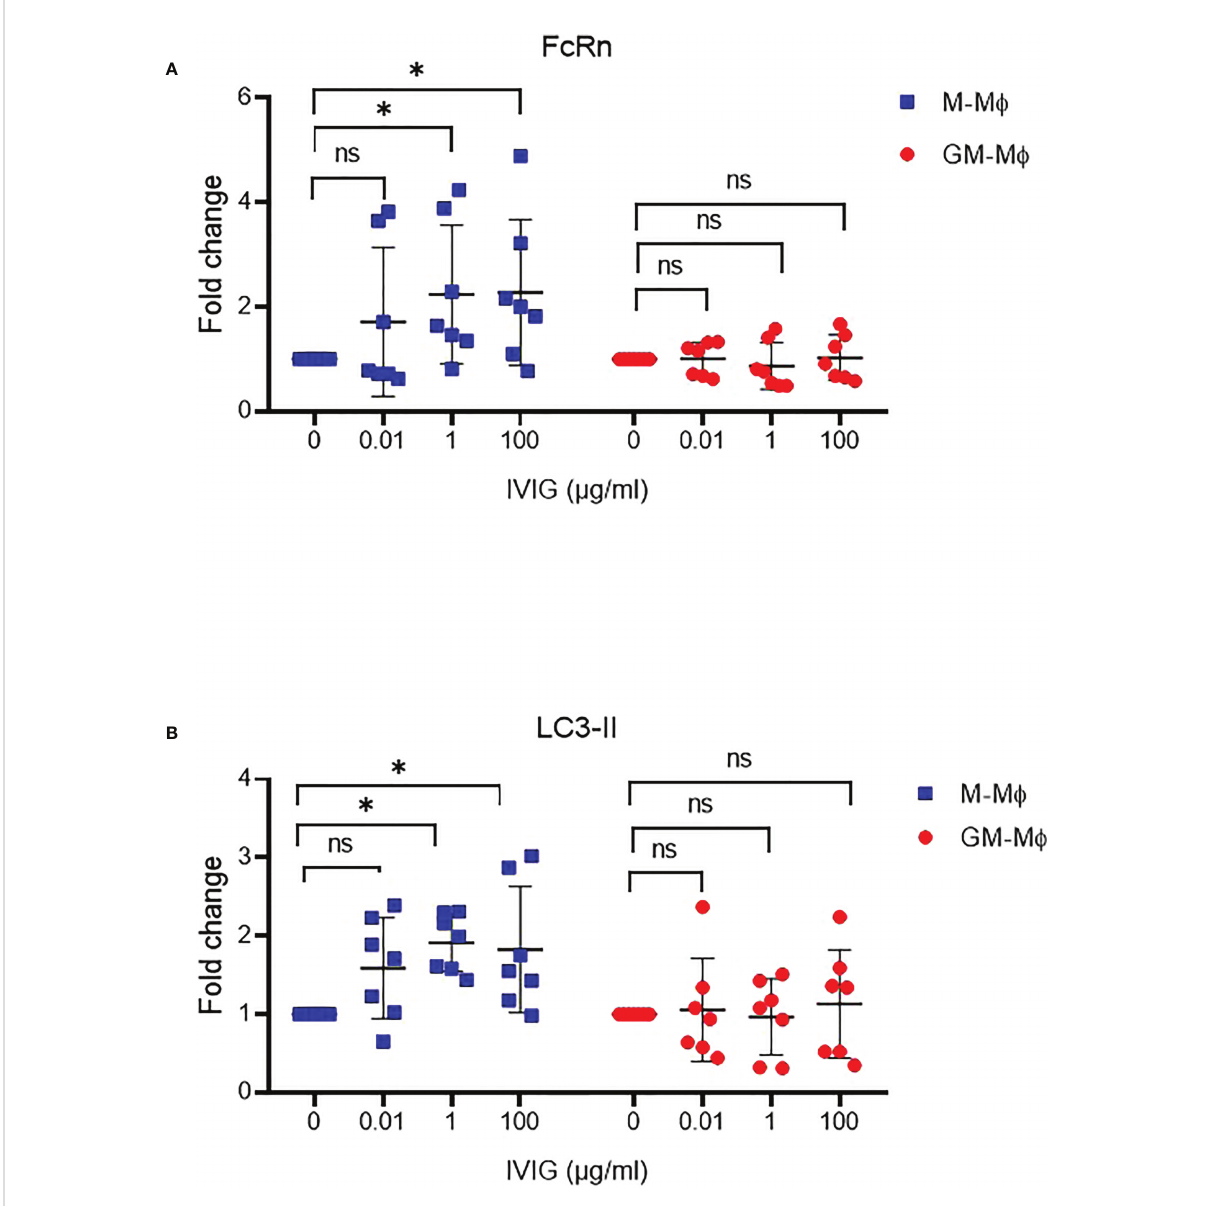
FIGURE 6 IVIG effect on FcRn expression and autophagy during macrophage differentiation. M-M f and GM-M f were cultured with IVIG 0.1, 1 and 100 µg/ ml during differentiation. Western blot analysis of fold change in protein expression for FcRn (A) and LC3-II (B) quanti fi cation and normalization to GAPDH expression (mean ± SD, N=7). M-M f , M-CSF – induced macrophages; GM-M f , GM-CSF – induced macrophages; IVIG, intravenous immunoglobulin G. ns = not signi fi cant and *p ≤